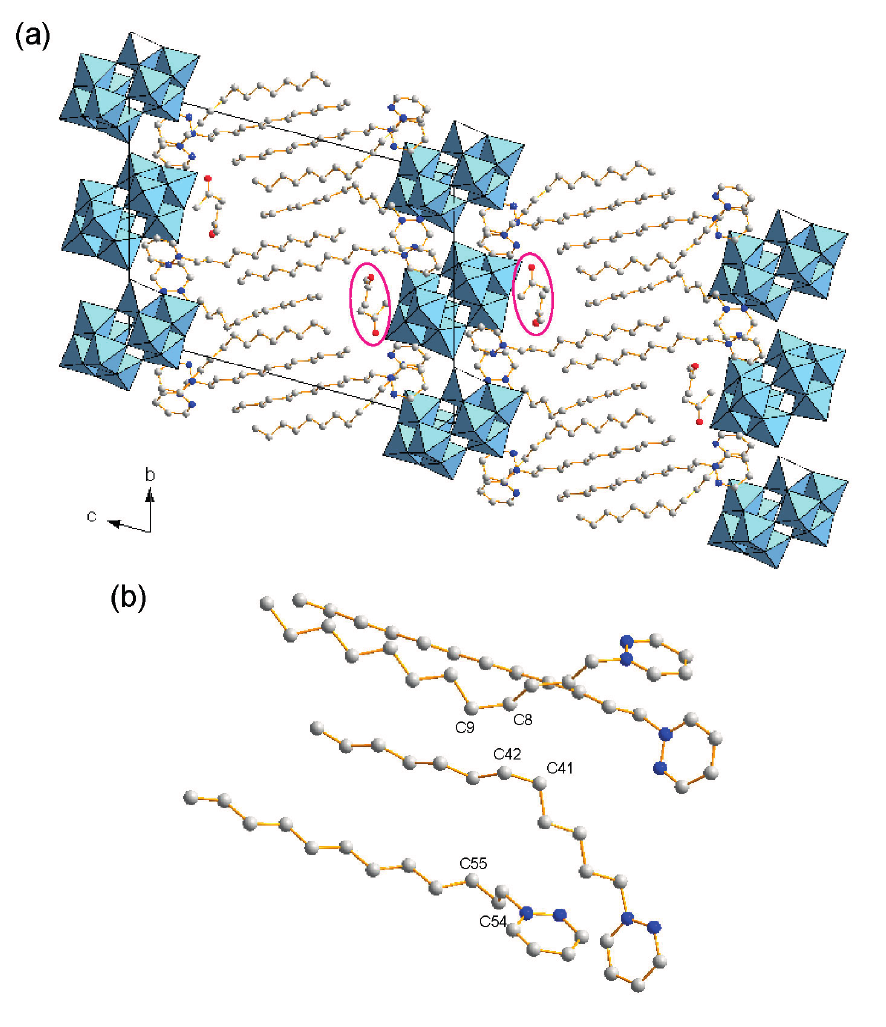
Figure 2. Crystal structure of 1 (C: gray, N: blue; W 10 anions in polyhedral representations. H atoms are omitted for clarity). ( a ) Packing diagram along the a axis. Some acetone molecules are highlighted; ( b ) View of crystallographically-independent surfactant